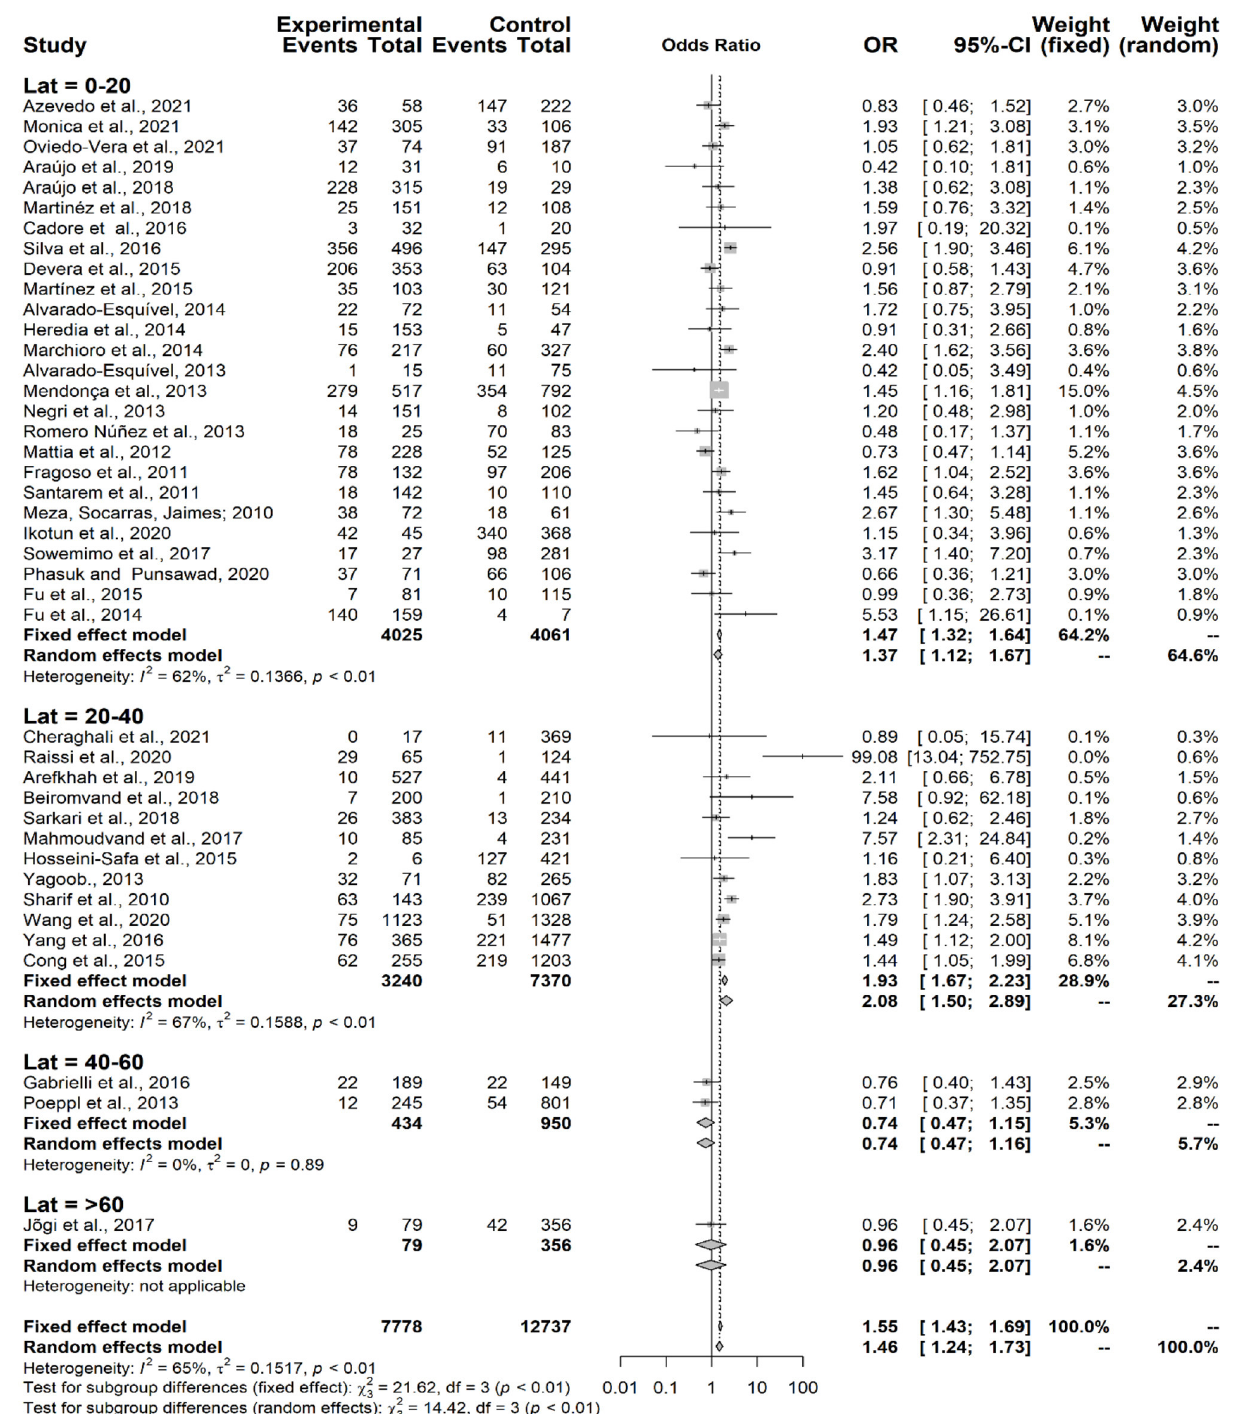
Frontiers in Public Health |